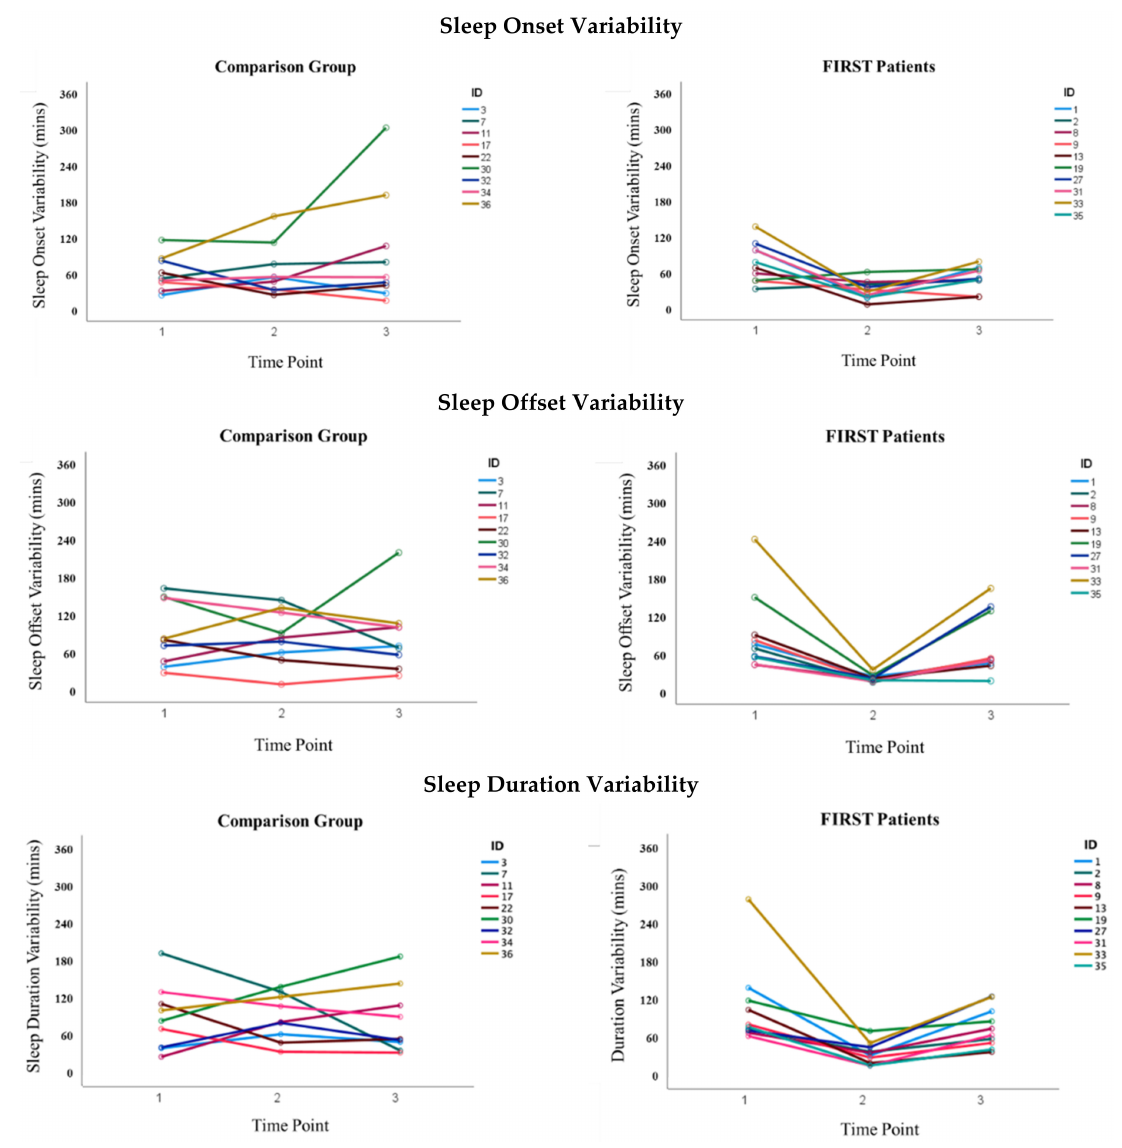
Figure 2. Graphs of estimated means across time points for all sleep outcomes by group. Notes: FIRST Patients = patients receiving IIPT through the Functional Independence Restoration (FIRST) Program; Comparison Group = similarly disabled sample receiving outpatient treatment as usual. Time points corresponded to before (baseline, Time 1), during (final IIPT week or equivalent time, Time 2), and following (post-discharge follow up or equivalent time, Time 3) inpatient